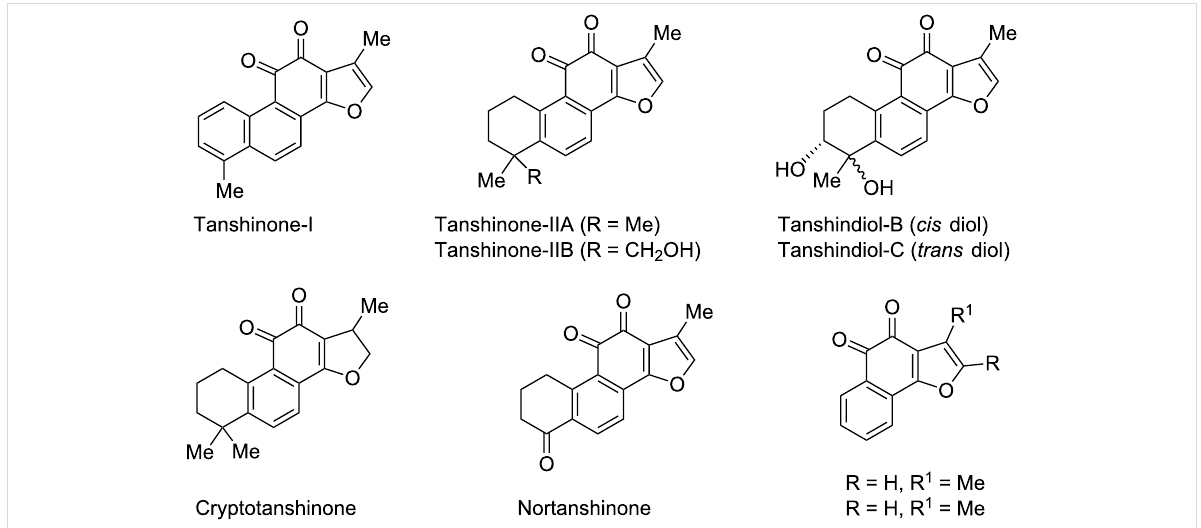
Figure 1: Some biologically active tetra cyclic furoquinone derivatives (isolated from Dan Shen ) and synthetic tricyclic furoquinones.